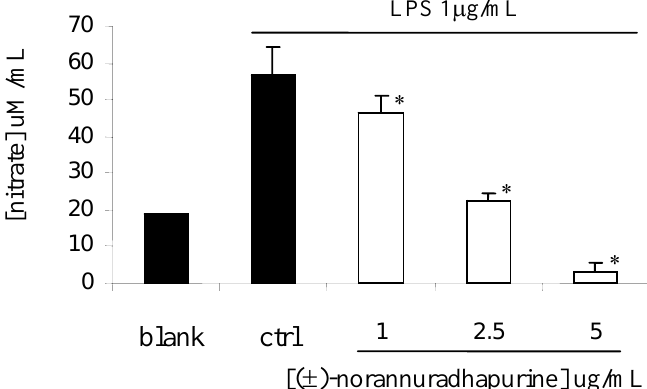
production in LPS-induced RAW 2